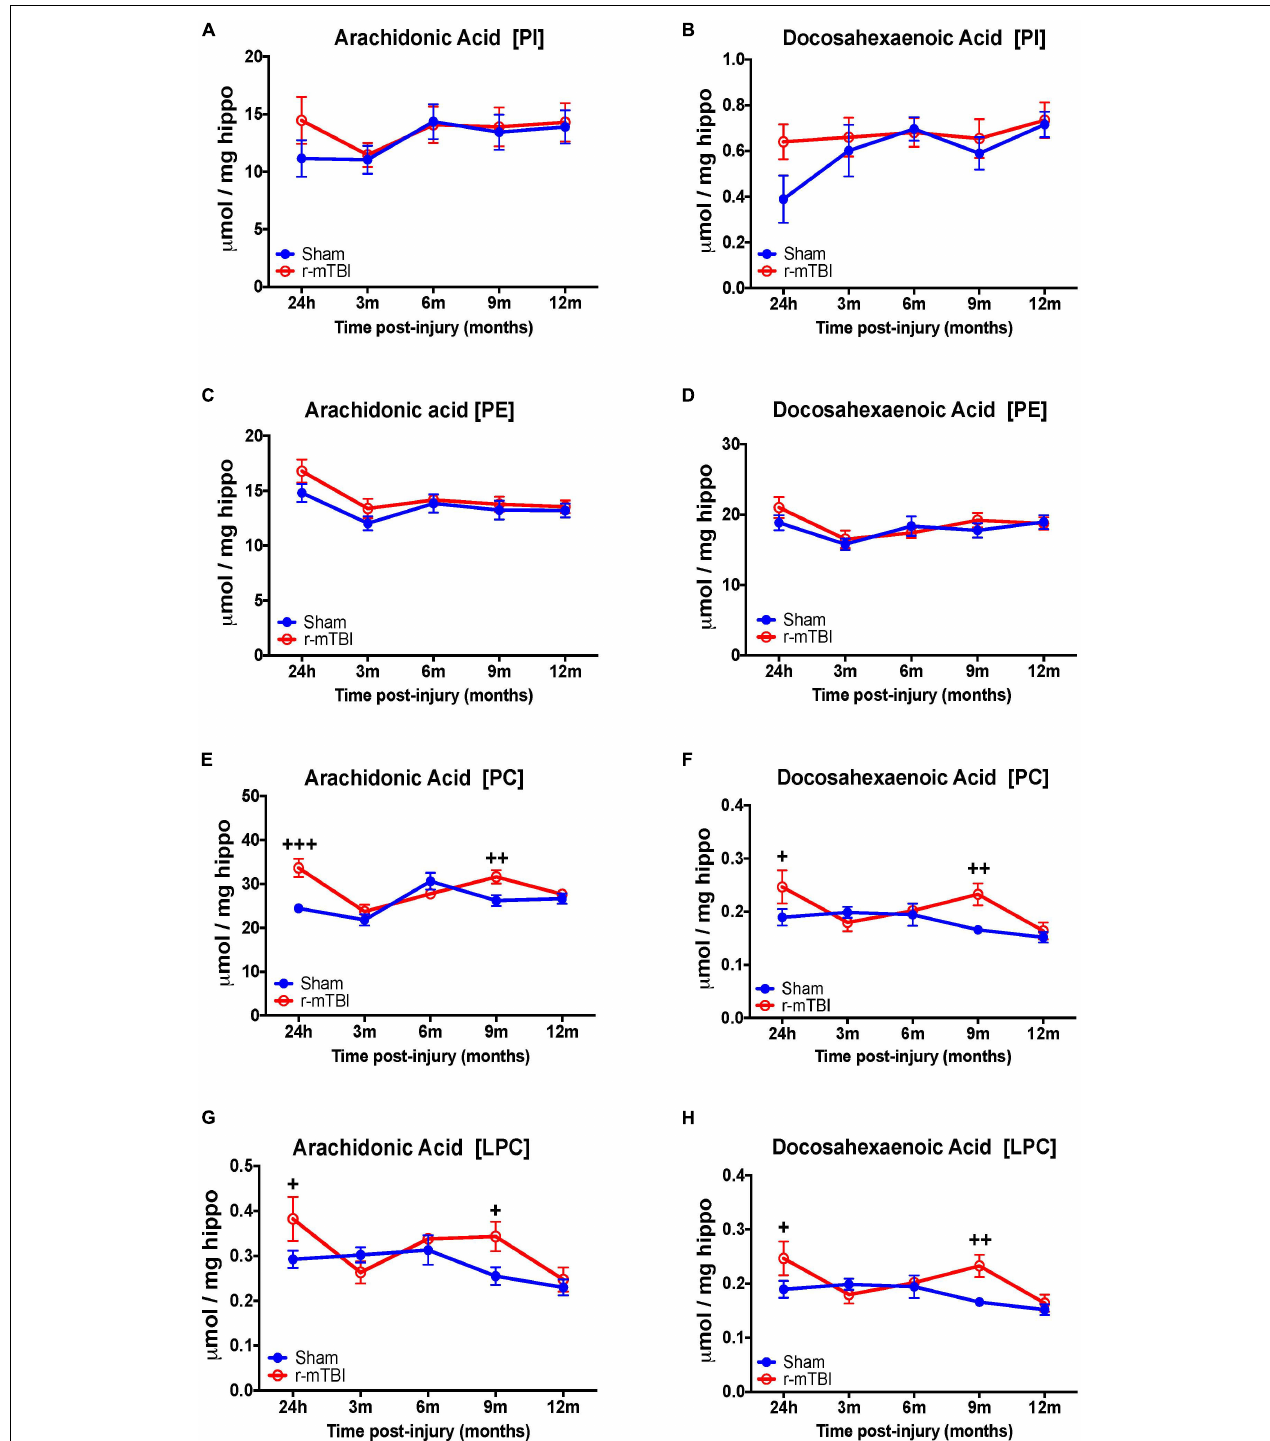
FIGURE 6 | Arachidonic acid and docosahexaenoic acid containing phospholipid species in the hippocampus of repetitive mTBI hTau mice. Significant changes in arachidonic acid and docosahexaenoic acid containing PI (A,B) , PE (C,D) , PC (E,F) , and LPC (G,H) species in the hippocampus of a model of repetitive-mTBI in hTau mice. Sample size for all groups across all time points is n = 4. Data represent mean µ mol per wet weight (5.5 mg) ± SEM. Individual molecular lipid species were quantified by liquid chromatography/mass spectrometry and were summed after LipidomeDB analyses to generate arachidonic and decosahexaenoic acid levels for each phospholipid species. Asterisks represent + P < 0.05, ++ P < 0.01, +++ P < 0.001 for comparisons between sham/r-mTBI mice. PE, phosphatidylethanolamine; PC, phosphatidylcholine; PI, phosphatidylinositol; LPC,